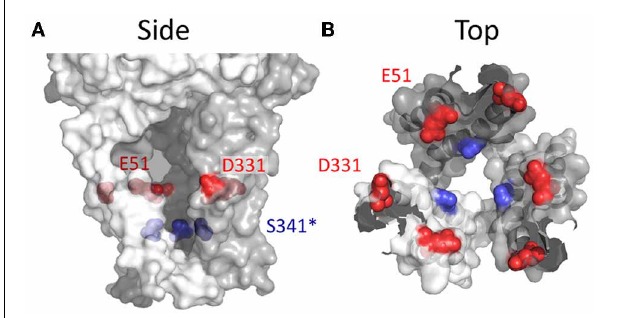
FIGURE 8 | Side chains affecting Ca 2 + selection and flux in P2X4R. (A) Side view of open state P2X4R homology model depicting residues known to regulate ion permeability. (B) P2X4R viewed from the extracellular vestibule looking intracellularly in the open configuration. Acidic side chain positions implicated in the regulation of Ca 2 + permeation, Glu 51 and Asp 331 are shown in red. The position highlighted in blue is Ser 341 , a conserved hydroxyl bearing side chain predicted to regulate Ca 2 + permeability based on data for the analogous position, Thr 336 , in